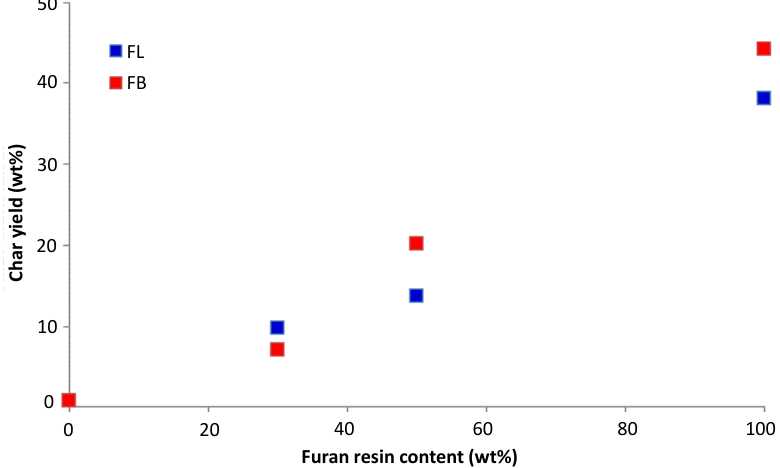
Figure 8. Plots of char yield from cone calorimetric experiments vs . resin composition for UP/FL resins (  ) and UP/FB resins ( 